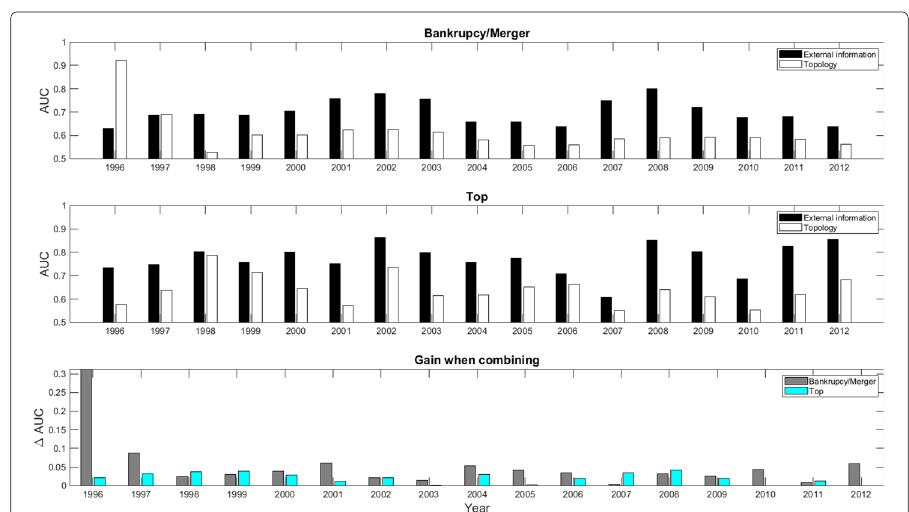
Fig. 9 (Upper and Middle) Comparison of AUC for logistic regression on external features and Random Forest Classifier on topological features for both collapsed and top companies. (Bottom) The gain in AUC for Random Forest on combined topological and external features for the collapsed and top companies